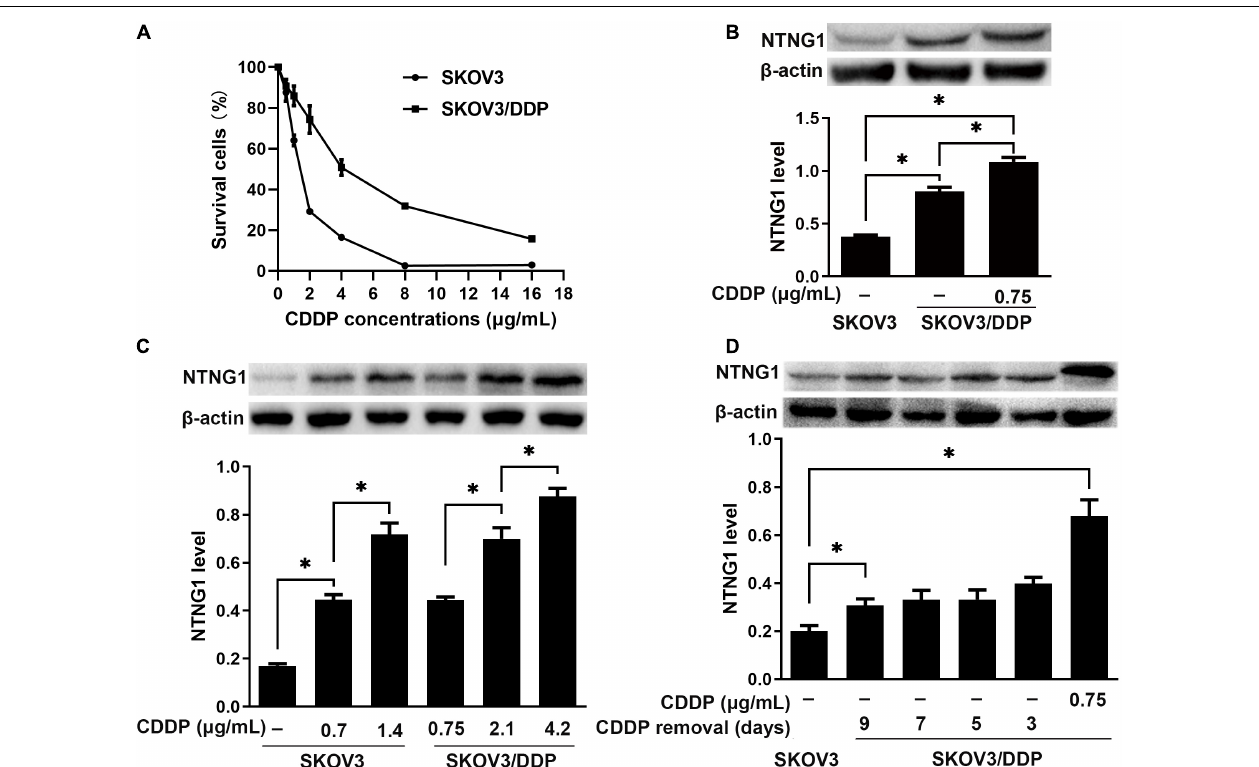
FIGURE 2 | The level of NTNG1 was increased in cisplatin-resistant ovarian cancer cells ( n = 3). (A) Cell survival (%) following cisplatin exposure; higher values were noted in SKOV3/DDP cells, confirming the resistance phenotype. (B) Expression level of NTNG1 was assayed by western blotting; the basal level in SKOV3/DDP cells (determined 5 days after cisplatin removal) was higher than that in SKOV3 cells; cisplatin induced its expression in SKOV3/DDP cells. (C) The level of NTNG1 increased with increasing concentration of cisplatin in SKOV3 and SKOV3/DDP cells. (D) The expression level of NTNG1 in SKOV3/DDP cells gradually decreased to the basal level following cisplatin removal. CDDP, cisplatin. ∗ p <